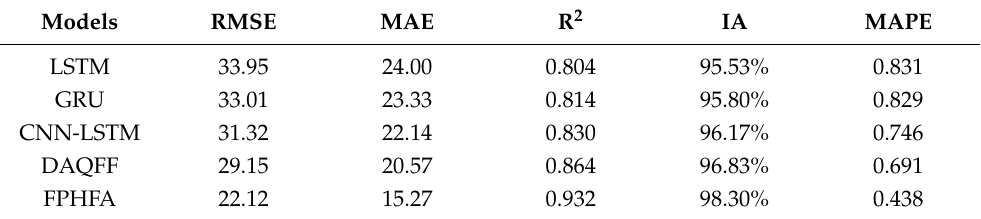
Table 3. The model performance evaluation indicators of FPHFA in long-term PM 2.5 concentration prediction in comparison to other comparison